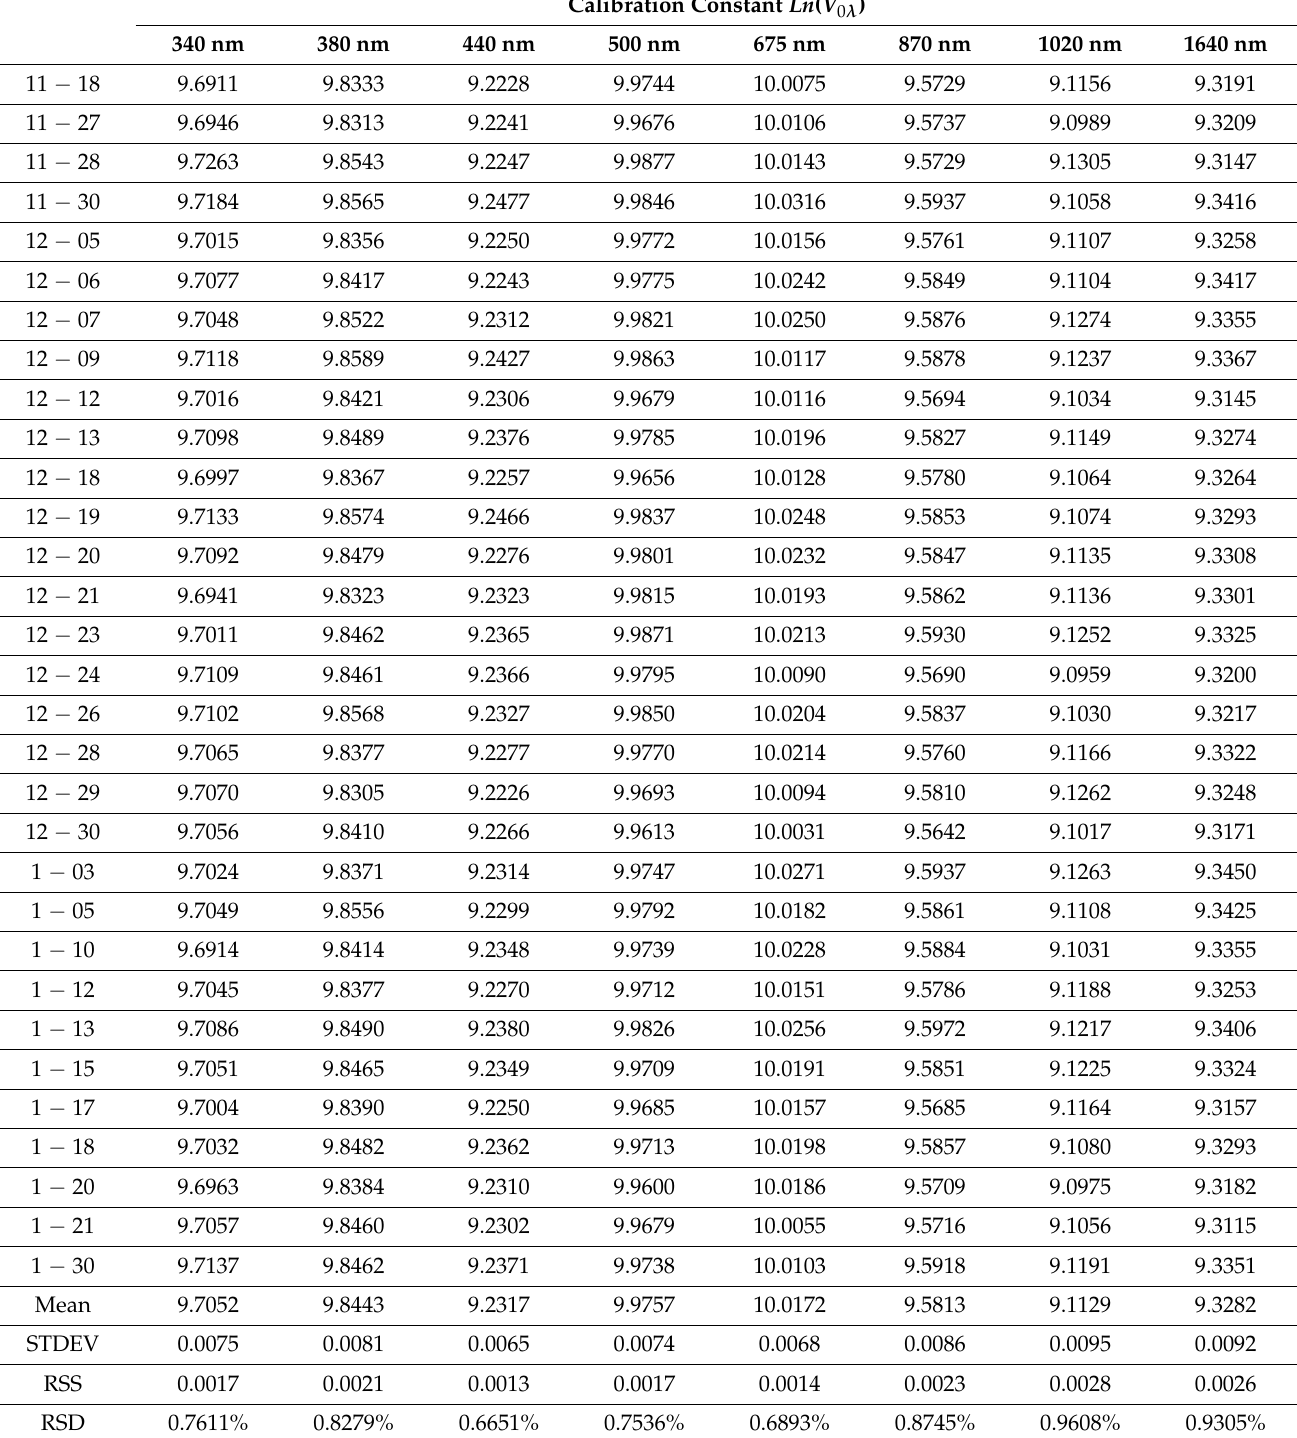
Table 4. Langley plot calibration results at the MFYD